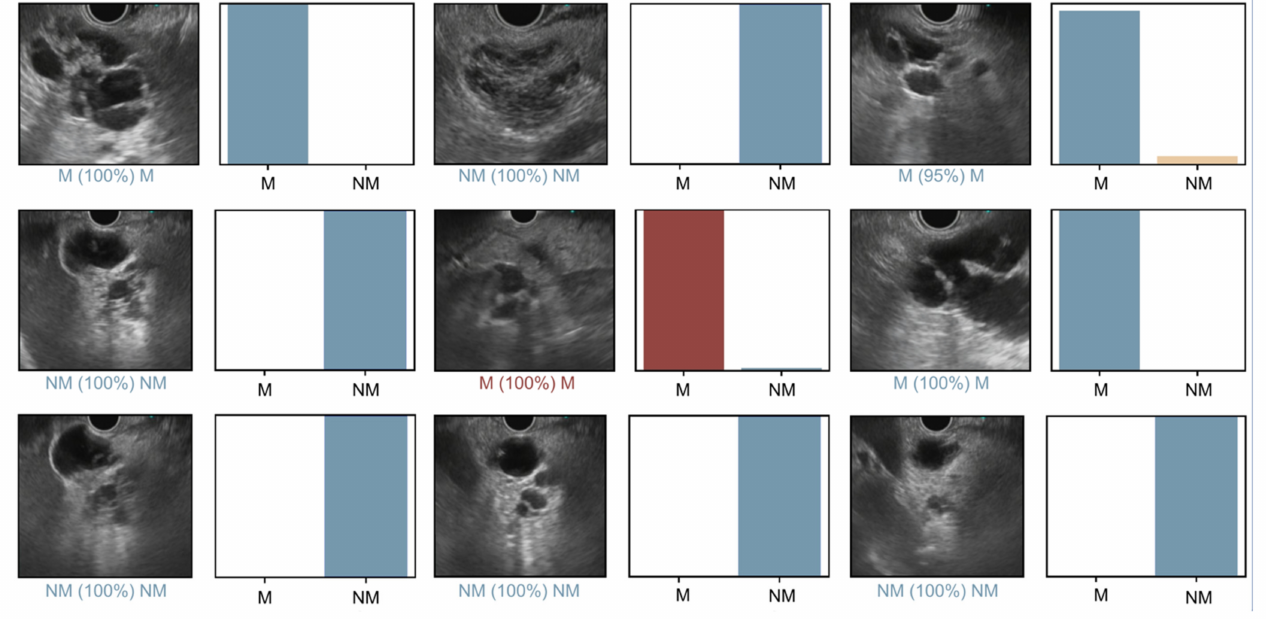
Figure 2. Output provided during the validation phase of the convolutional neural network. The bars represent the probability estimated by the algorithm. The finding with the highest probability was outputted as the predicted classification. A blue bar represents a correct prediction. Red bars represent an incorrect prediction. M—mucinous pancreatic cystic lesion; NM—non-mucinous pancreatic cystic